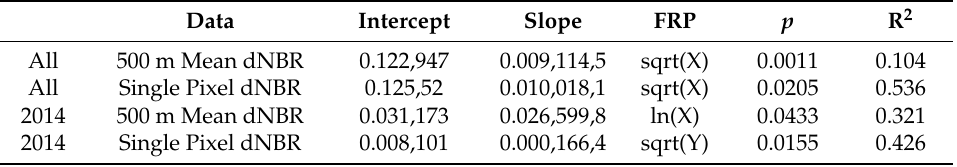
Table 7. Regressions between dNBR and MODIS fire radiative power for select fires.